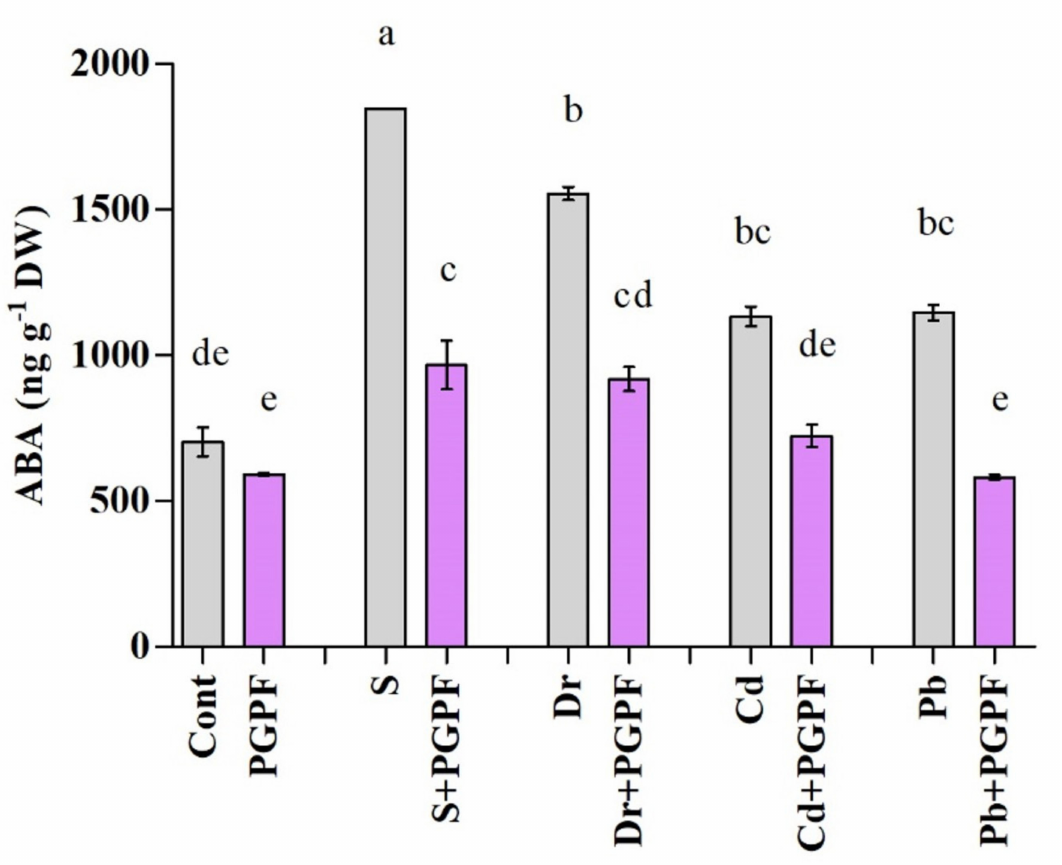
Figure 5. Abscisic acid (ABA) content in leaves of tomato plants grown under normal and stress conditions and inoculated with PGPF for 10 days. Treatments: Cont (control), PGPF ( Cunninghamella bertholletiae ), S (1.5% sodium chloride), S (1.5% sodium chloride) + PGPF ( Cunninghamella bertholletiae ), Dr (25% polyethylene glycol), Dr (25% polyethylene glycol) + PGPF ( Cunninghamella bertholletiae ), Cd (3 mM cadmium), Cd (3 mM cadmium) + PGPF ( Cunninghamella bertholletiae ), Pb (3 mM lead), and Pb (3 mM lead) + PGPF ( Cunninghamella bertholletiae ). Values are shown as the means ± SD ( n = 5) and significant differences at p < 0.05 (Tukey test) are indicated by different lowercase letters above the